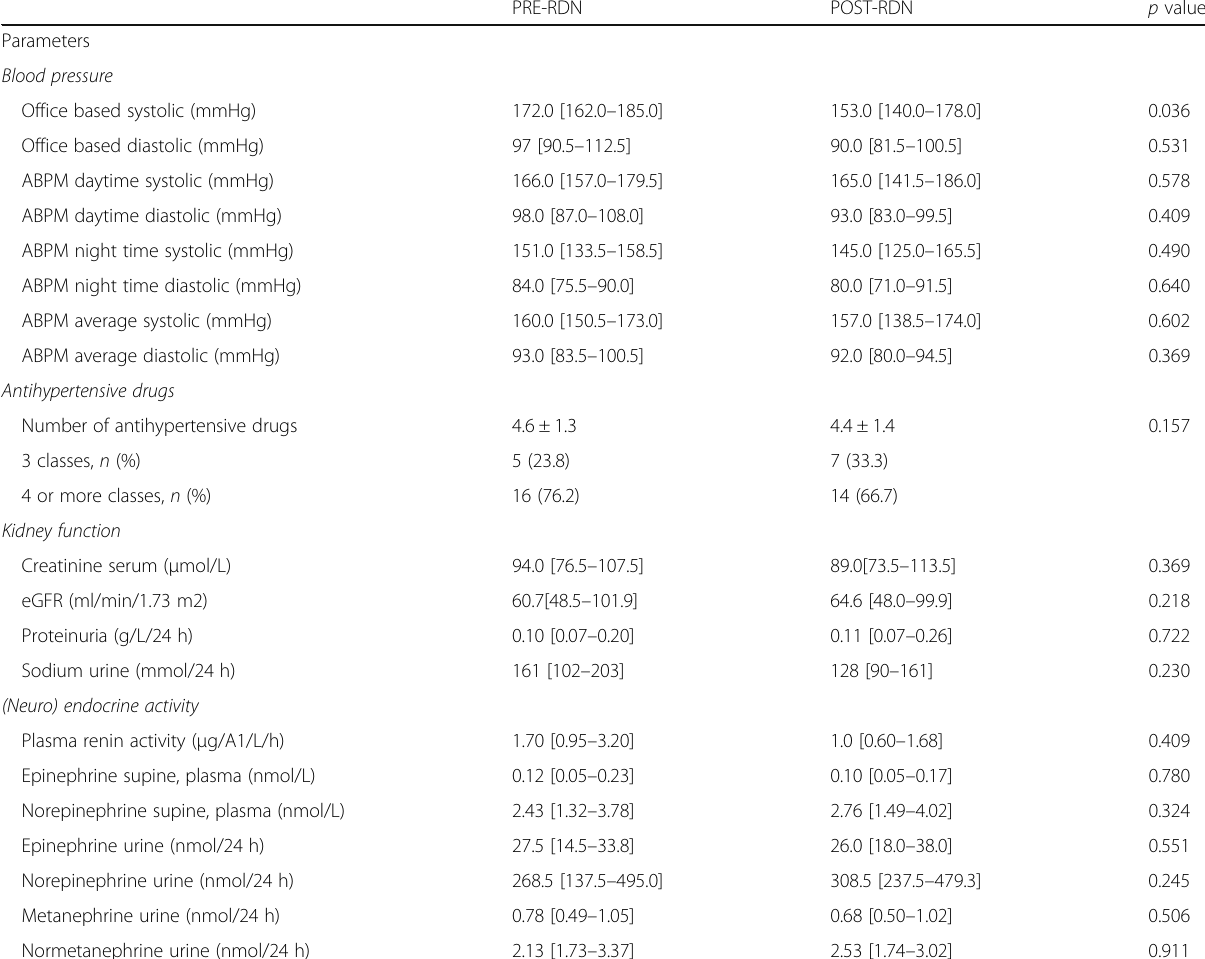
Table 3 Blood pressure, kidney function and